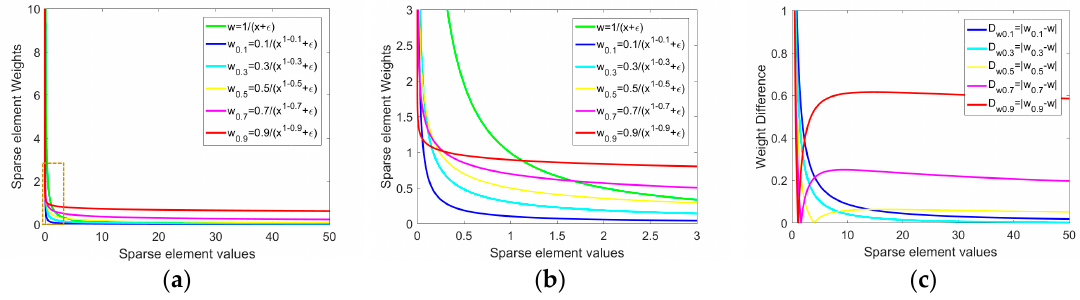
Figure 3. Illustration of weighted function. ( a ) Penalty curves of the traditional weighted function and the new weighted function with q from 0.1 to 0.9 in interval 0.2. (cid:15) sets 0.001. ( b ) Magnified map of the brown rectangular area. ( c ) Weight difference between the traditional weight and the new weight varying q from 0.1 to 0.9 with interval 0.2.